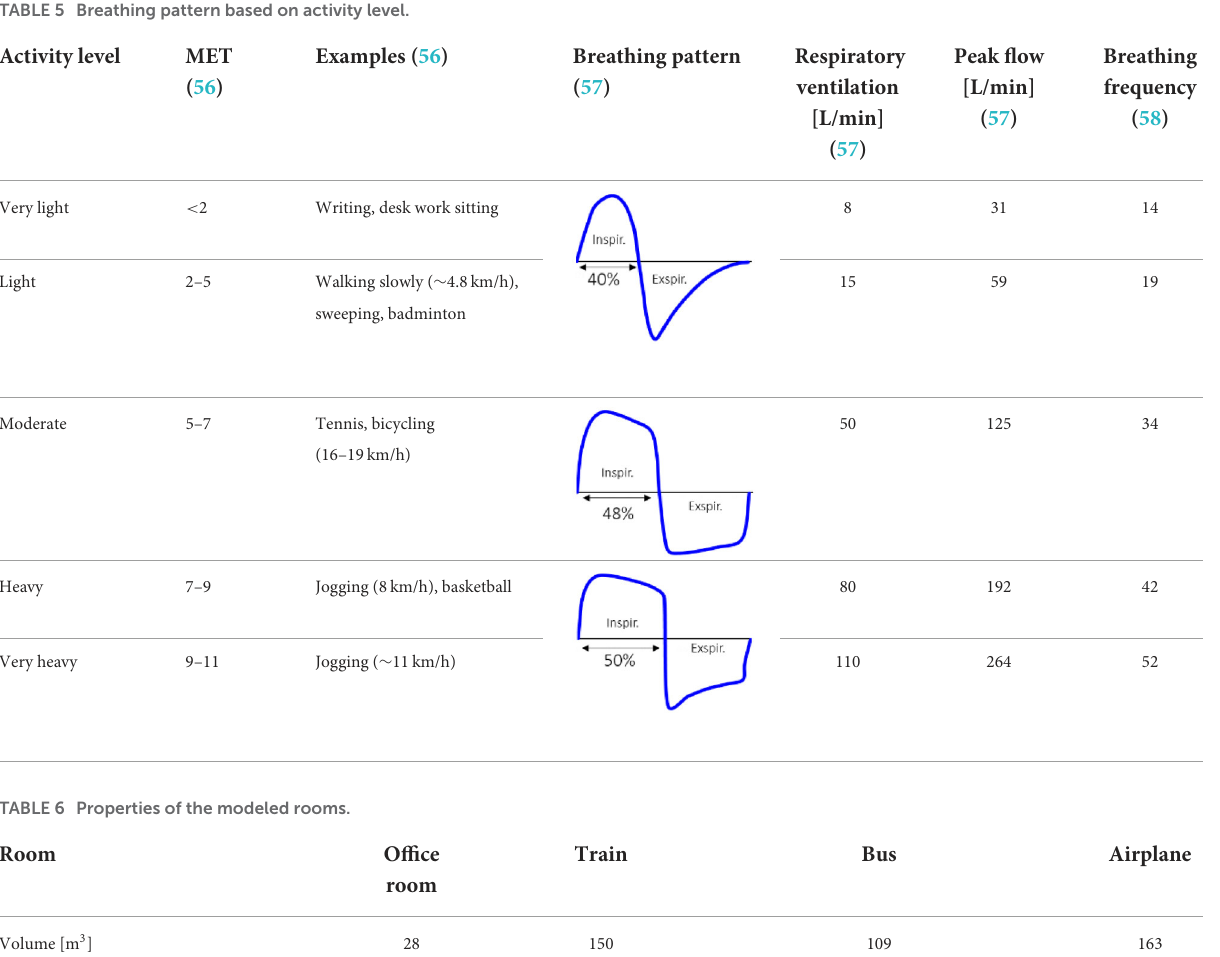
TABLE 5 Breathing pattern based on activity level.